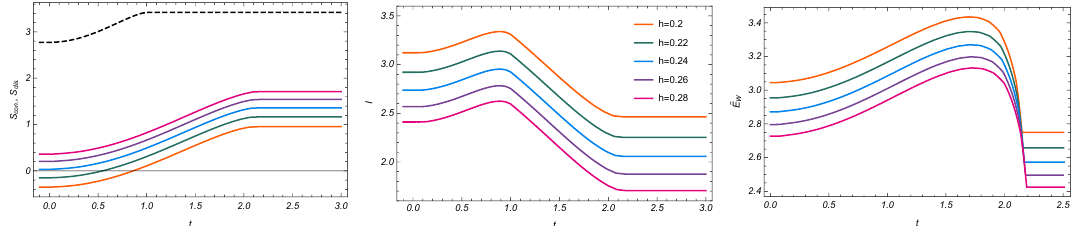
Figure 6 . Left : the HEE for connected (solid) and disconnected (dashed) con(cid:12)gurations for di(cid:11)erent values of the separation between subregions. The connected con(cid:12)guration is always favored for any boundary time. Middle : the HMI as a function of time which is positive during the entire evolution. Right : the EWCS as a function of boundary time which saturates to a (cid:12)nite value. Here we have set ‘ =